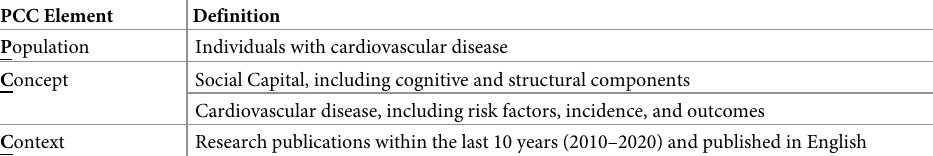
Table 1. PCC framework for identifying the main concepts of the scoping review